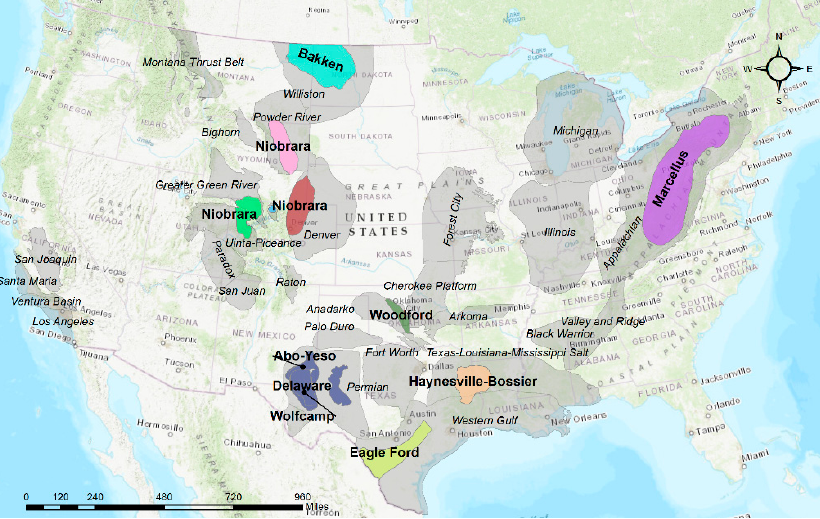
Figure 1. U.S. oil basins and major shale plays [5,6].